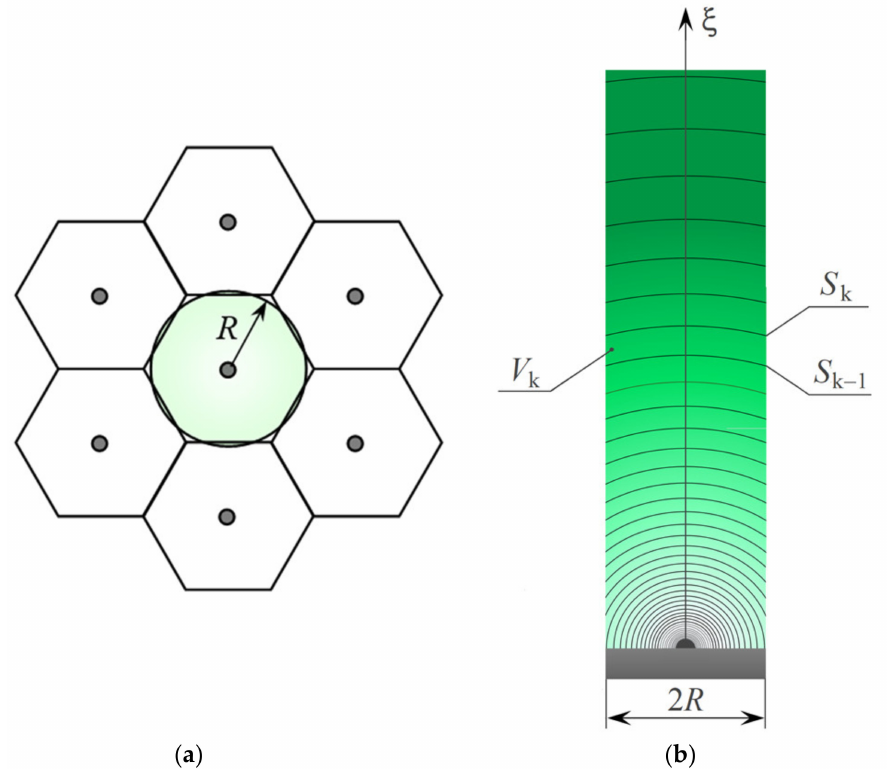
Figure 1. ( a ) Part of a hexagonal ensemble (a top view); ( b ) Cross section of the virtual diffusion cylinder of the nucleus equidistant from six similar neighbors. The scheme illustrates the change in the concentration of depositing ions (via a color gradient) and the mass transfer conditions inside a virtual cylinder with a base radius R due to the growth of a nucleus within the